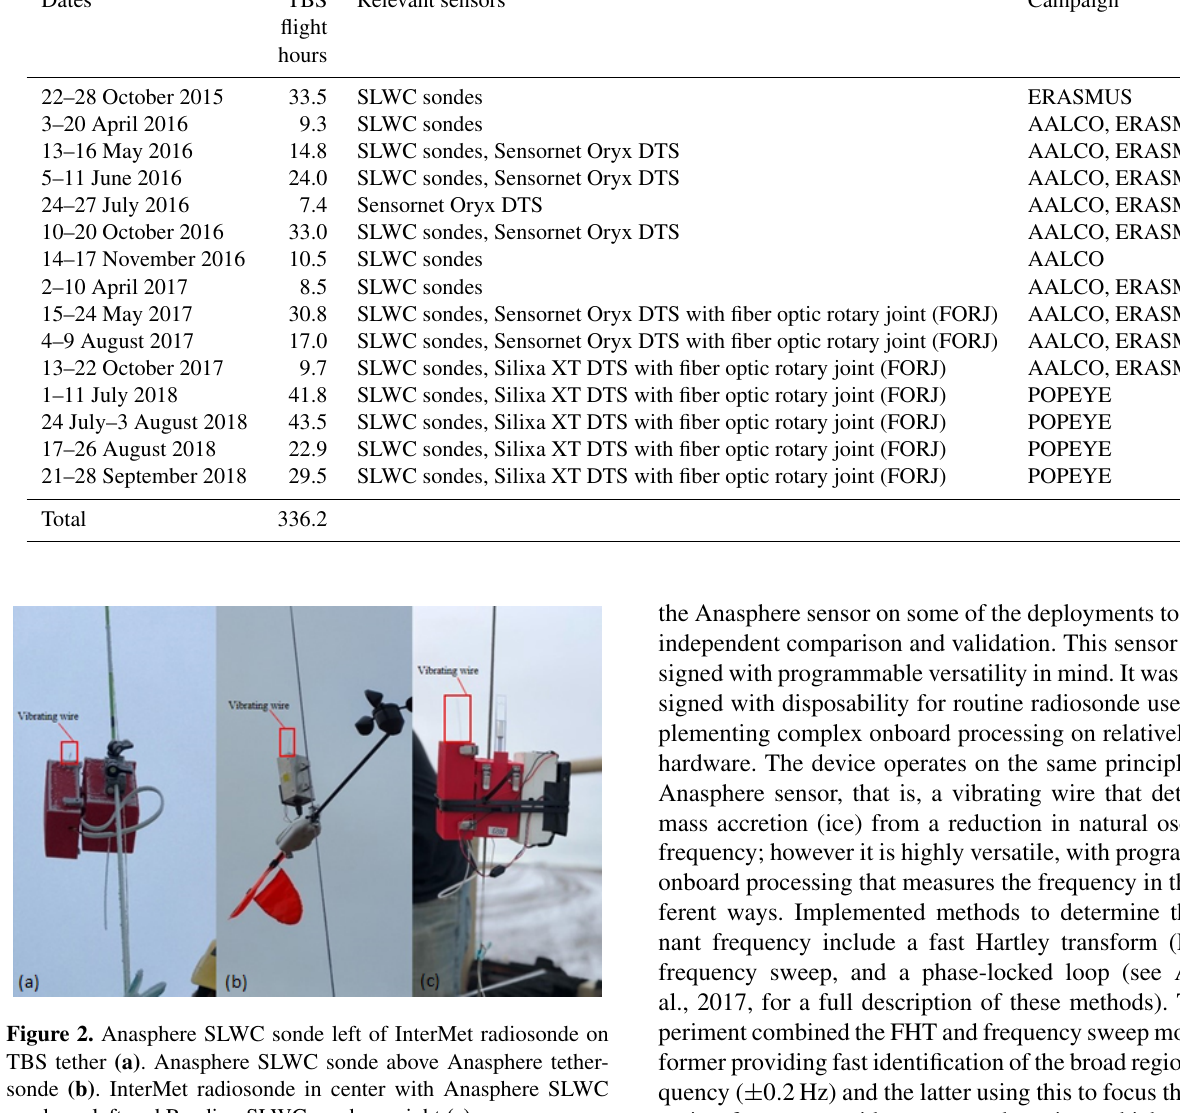
Table 1. Overview of TBS flights analyzed within this study including date, duration, sensor payload, and campaign. Dates